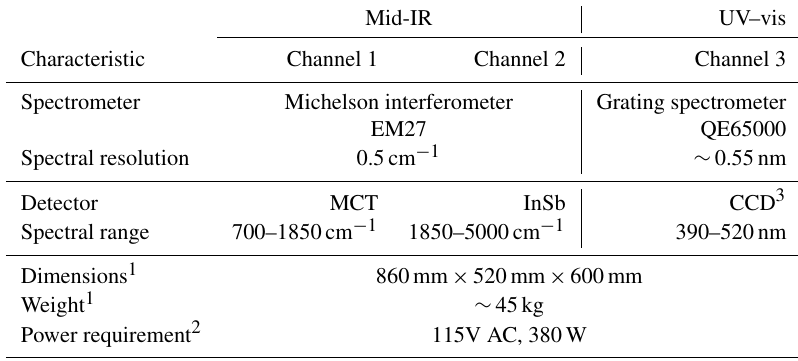
Coheur et al., 2007; Fischer et al., 2008; Glatthor et al., 2009; Höpfner et al., 2016), SCIAMACHY with a ground pixel size of 15 × 26 km 2 and Ozone Monitoring Instrument (OMI) with a resolution of 13 × 24 km 2 for NO 2 (Boersma